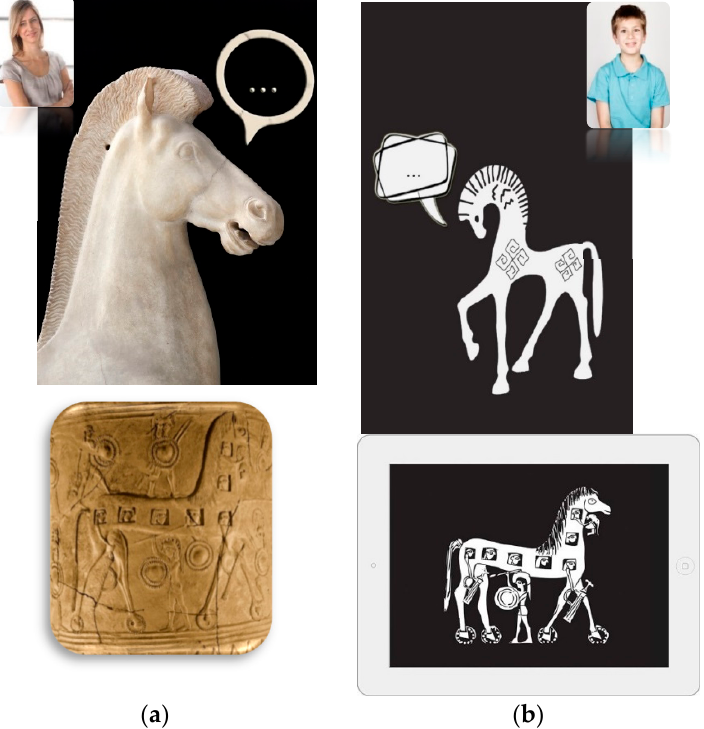
Figure A1. The same story becomes a different experience, adapting the plot, media assets and narration style to different personas; here the horse character in the version of the story for ( a ) an art enthusiast; ( b ) a young visitor who prefers a more exploratory, action-packed